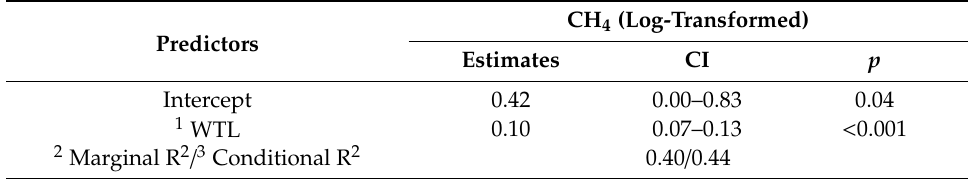
Table 2. Estimates of the mixed-e ff ect model as well as the predictors, p values, and marginal and conditional R 2 .